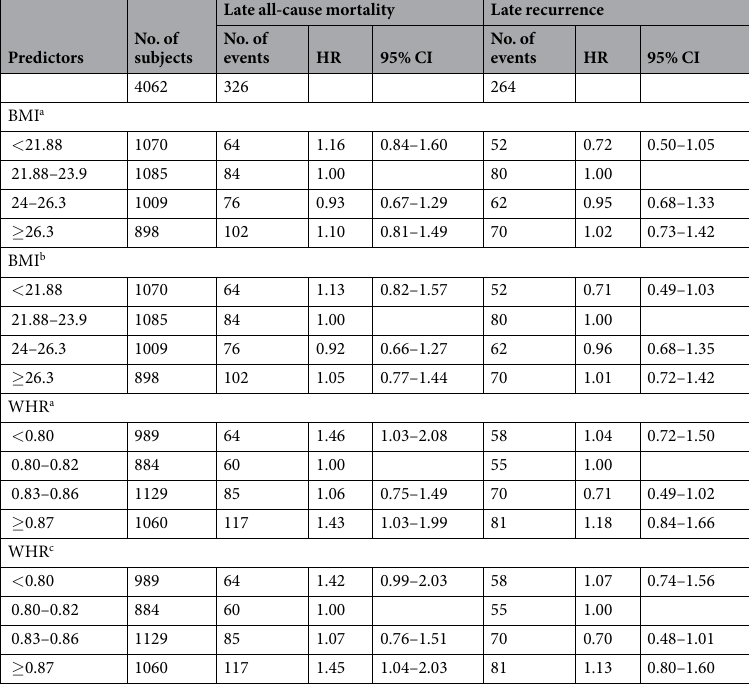
correlation coefficient demonstrated that WHR was more correlated with waist circumference ( r = 0.75) than hip circumference ( r = 0.25).